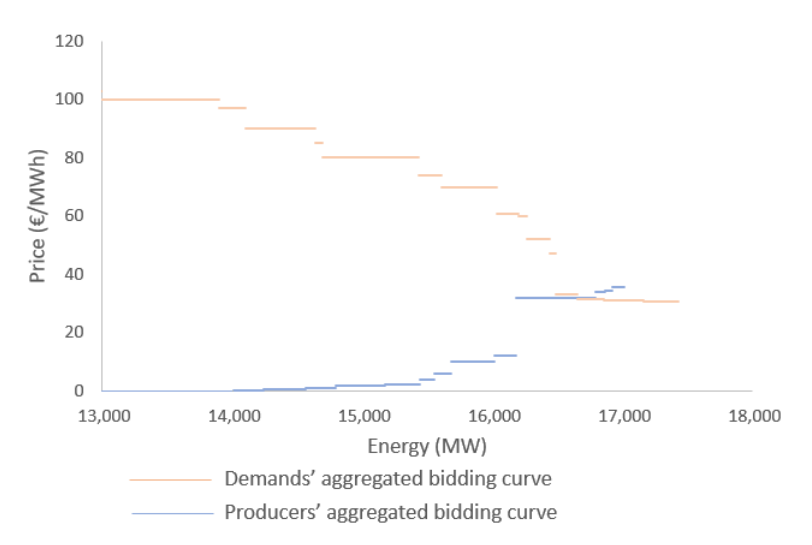
Figure 3. Aggregated market curves for a given hour. The resulting function is not